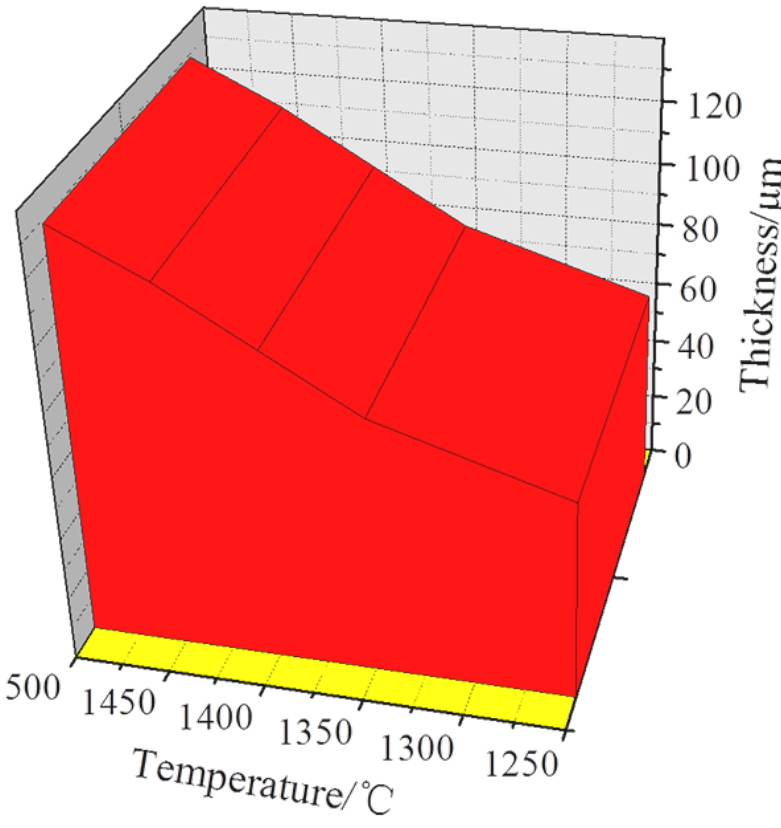
Figure 11. Relationship between sintering temperature and the interfacial layer thickness.